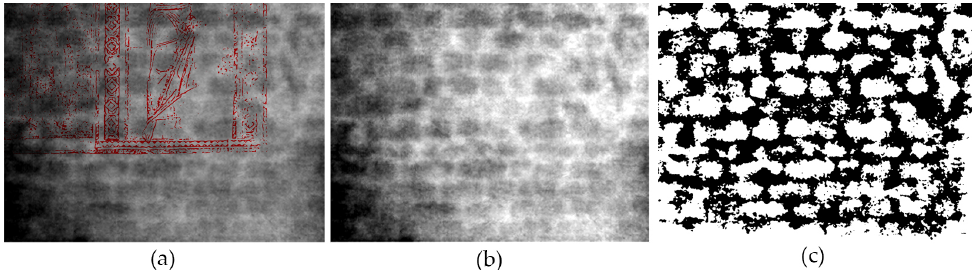
Figure 10. Thermal analysis closer than the previous one to the masonry surface: ( a ) Initial thermal image, in red lines, schematized the overlapped fresco. ( b ) Thermal image with improved contrast. ( c ) Final binary image (see the cone of vision B in Figure